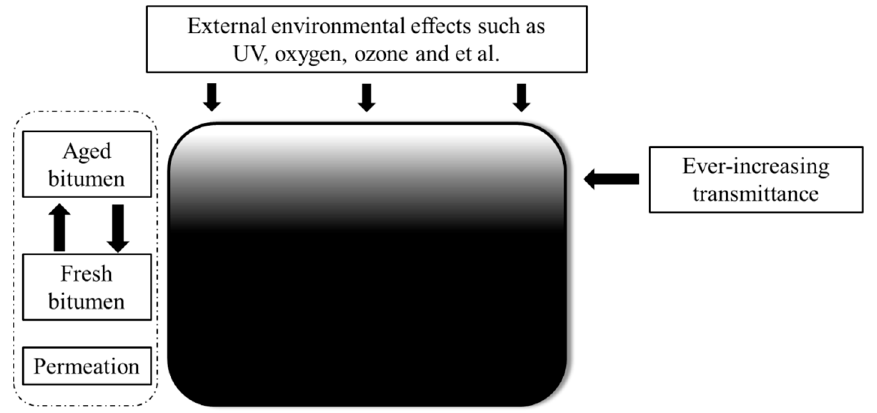
Figure 17. UV aging model.